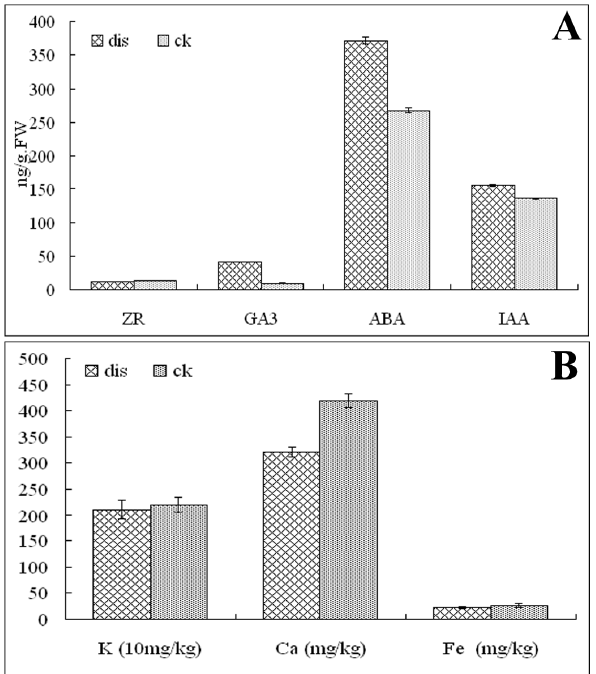
Figure 5. Phytohormone and mineral content differences in the normal control (CK) and surface brown spots disease (SBS) fruit. A: Phytohormone contents in the CK and SBS fruit; B: mineral element contents in the CK and SBS fruit. Phytohormones were measured using the ELISA method, and mineral elements were measured using atomic absorption spectrometry. Three independent repetitions for each test and 5 fruits from each sample were measured; the average values and standard deviations are